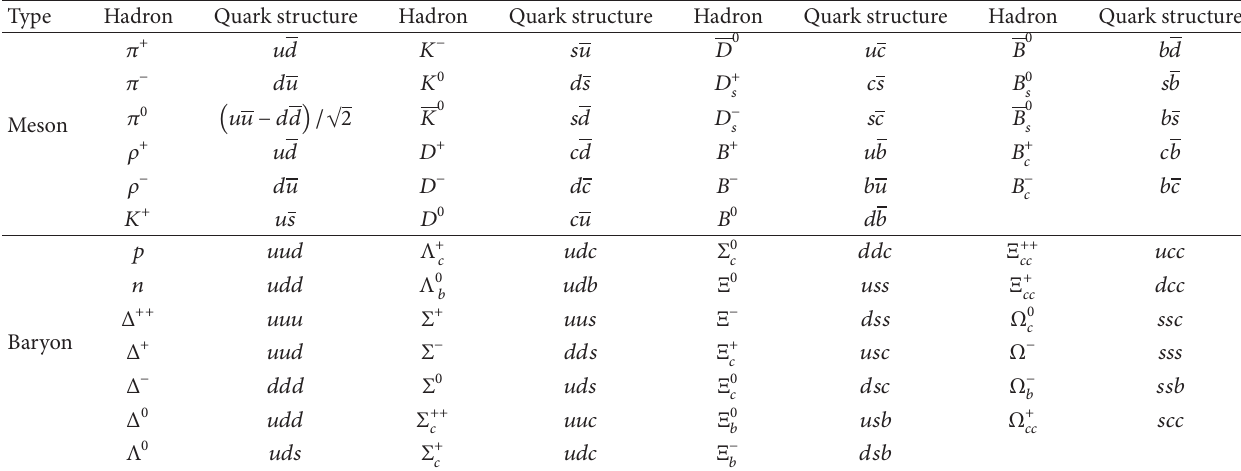
Table 1: The quark structures of some hadrons